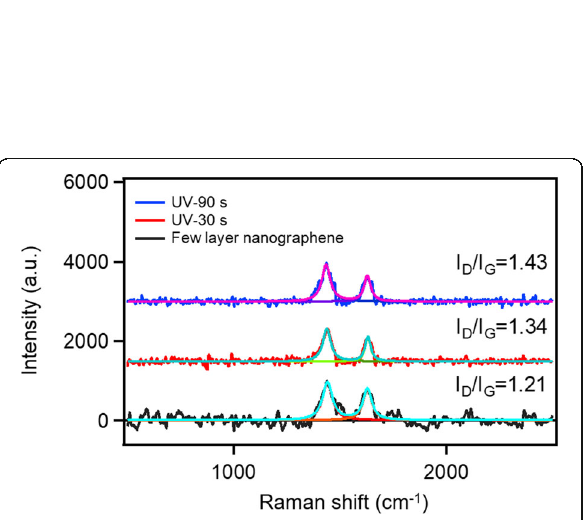
Fig. 3 Raman spectra of few layer nano-graphene under various UV exposure